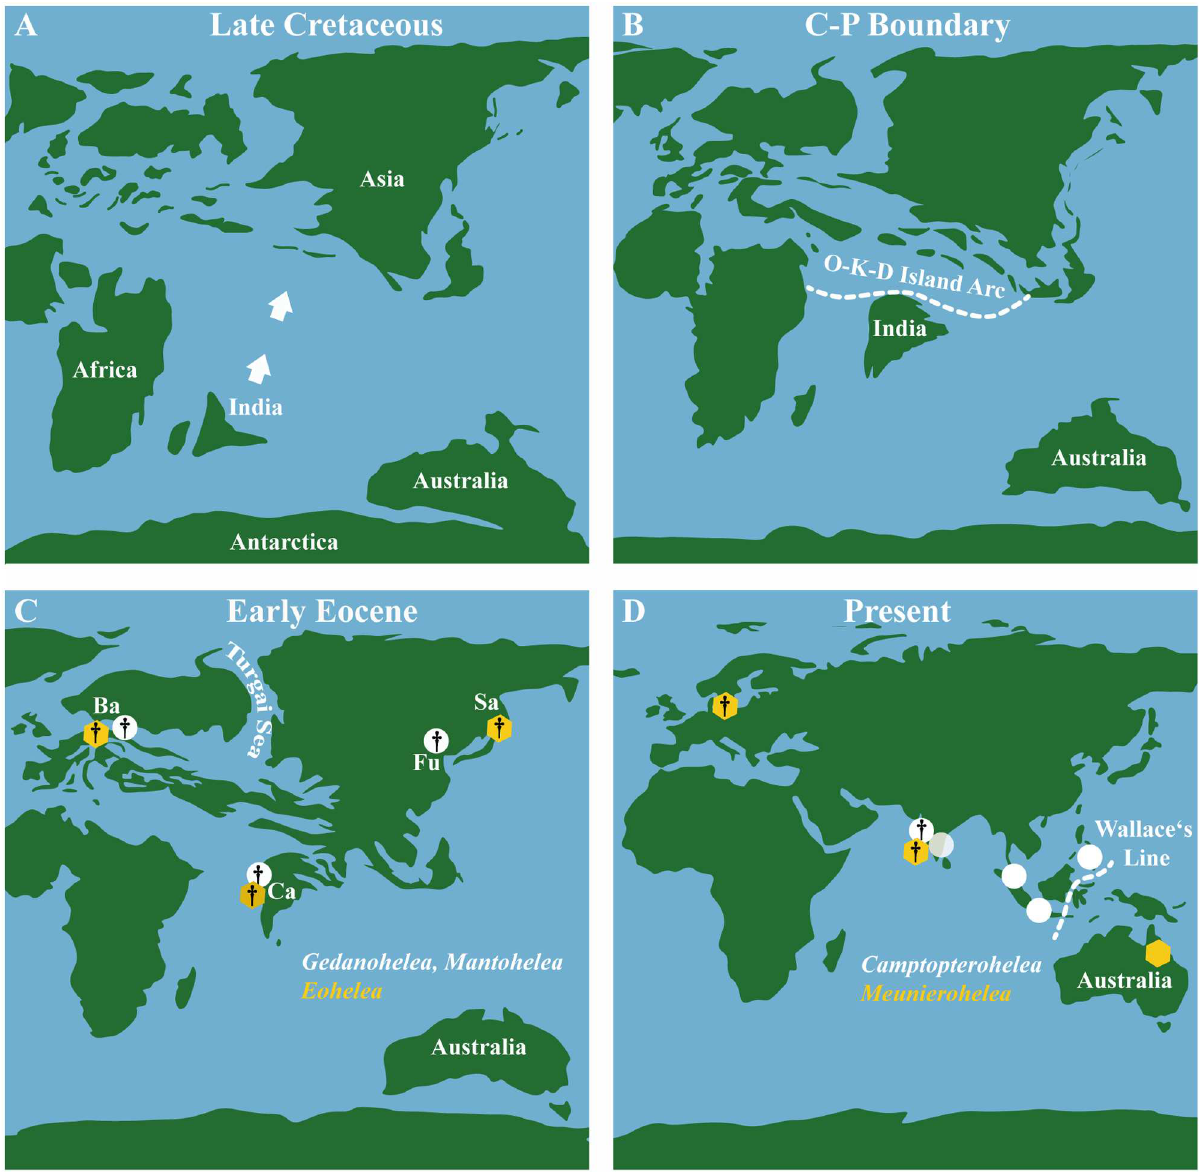
Fig 10. Plate tectonic history of the Indian subcontinent from the Late Cretaceous to Present and distribution of select biting midge taxa (maps modified after data supplied by “Global Paleogeography and Tectonics in Deep Time 2016 Colorado Plateau Geosystems Inc.”). A . Late Cretaceous. B . Cretaceous-PaleogeneBoundary. Dashedlines showingpossibledispersalroutes between India and Africa/Asia (Oman-Kohistan-Dras Island Arc, summarized in Chatterjee& Scotese [5]). C . Early Eocene. Circles and hexagon showingfossil (†) generaof Gedanohelea , Mantohelea and Eohelea in Eoceneambers. Abbreviations: Ba = amber from the Baltic Region, Ca = Cambay amber, Fu = Fushun amber, Sa = Sakhalin amber. D . Present. Circles and hexagonshowingfossil (†) generain Eocene ambers and recent representatives of Meunierohelea and Camptopterohelea